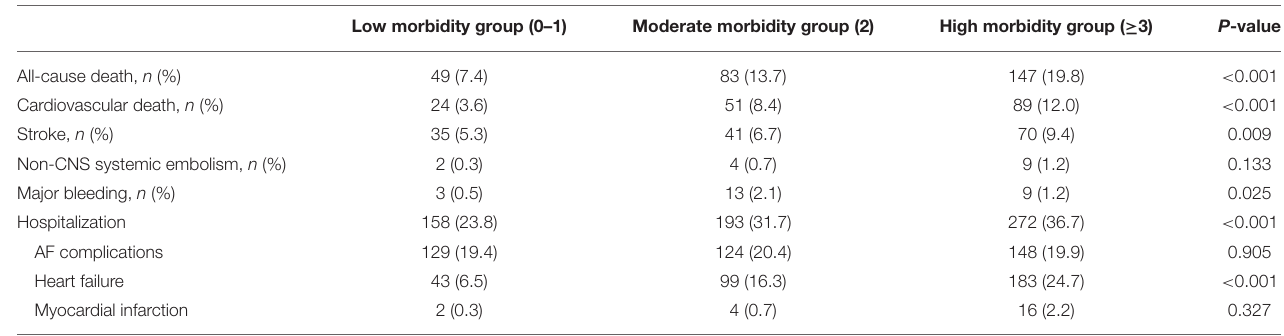
TABLE 2 | Outcome event rates at 12 months in morbidity categories in